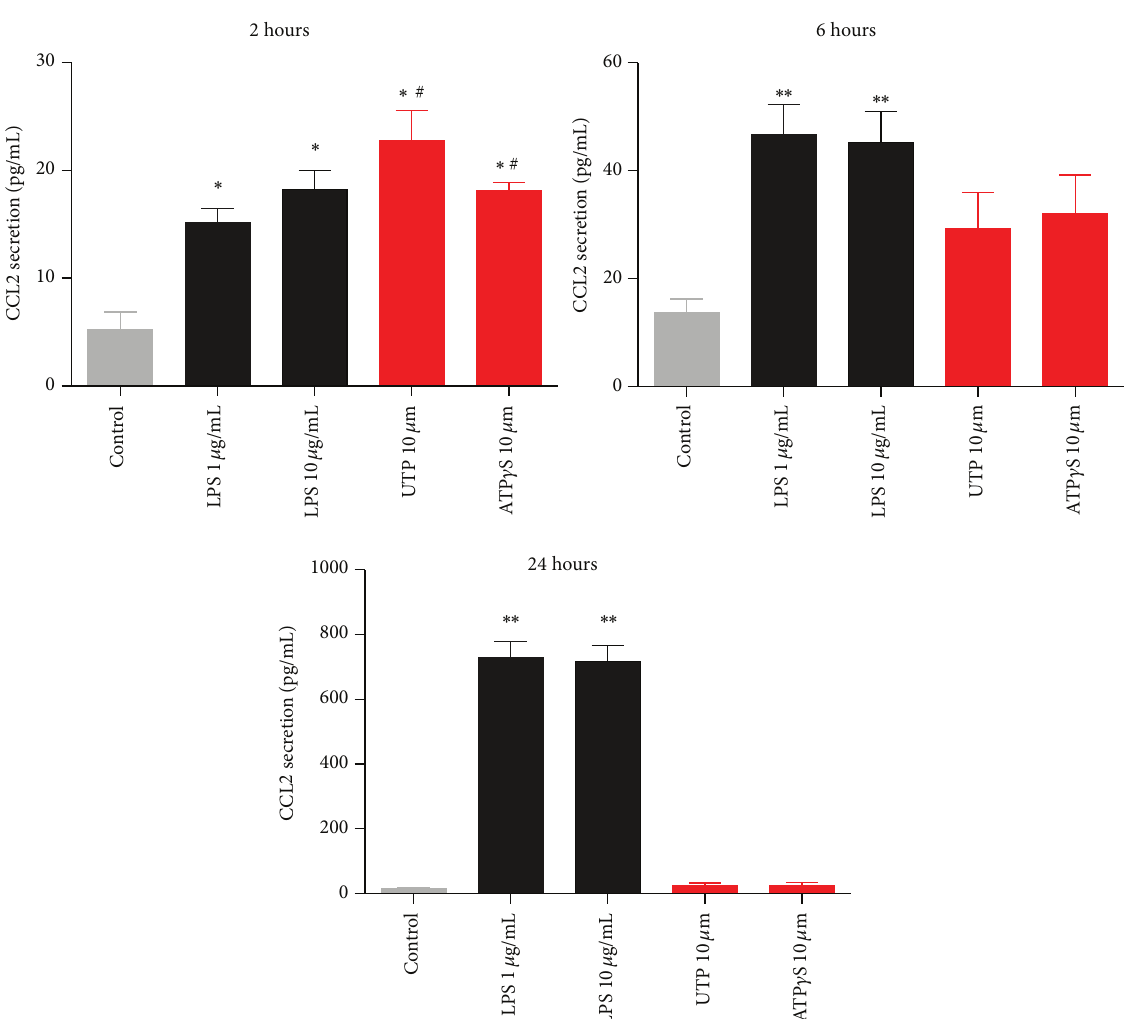
Figure 2: The effect of P2Y2 agonists compared with LPS on CCL2 secretion from unprimed THP-1 cells. THP-1 cells were plated in RPMI media containing 1% serum and stimulated with media alone, LPS (1 or 10 𝜇 g/mL), UTP (10 𝜇 M), or ATP 𝛾 S (10 𝜇 M) for the times indicated above each graph. Mean raw data is plotted in pg/mL ± SEM from three independent experiments. Symbols: ∗ denotes 𝑃 < 0.05 compared with control, # denotes no significant difference between treatments, and ns denotes not significant with respect to control (one-way ANOVA with Tukey’s post hoc test). Standard curves were performed for each ELISA experiment with fits of 𝑟 > 0.95 .